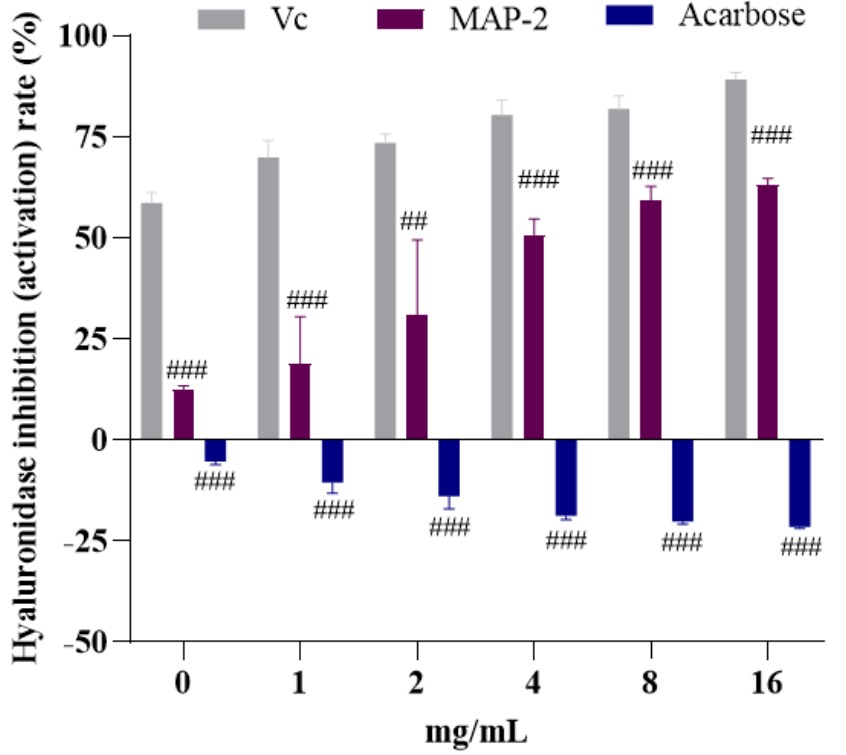
Figure 8. Effects of MAP−2 and Acarbose on hyaluronidase activity. ## p < 0.01, ### p < 0.001.